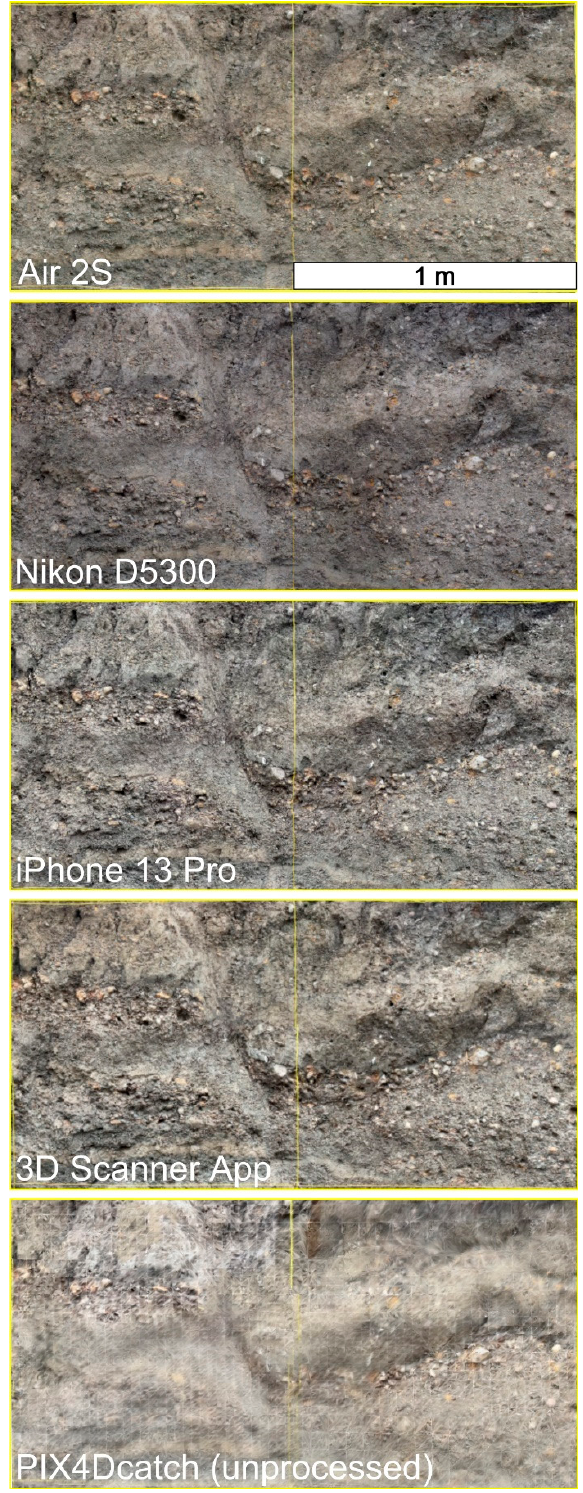
Figure 5. Detailed view of the reconstructed scene (2 × 1 m) using different 3D image capture sys ‐ tems and showing one sidewall of the studied sinkhole. and showing one sidewall of the studied